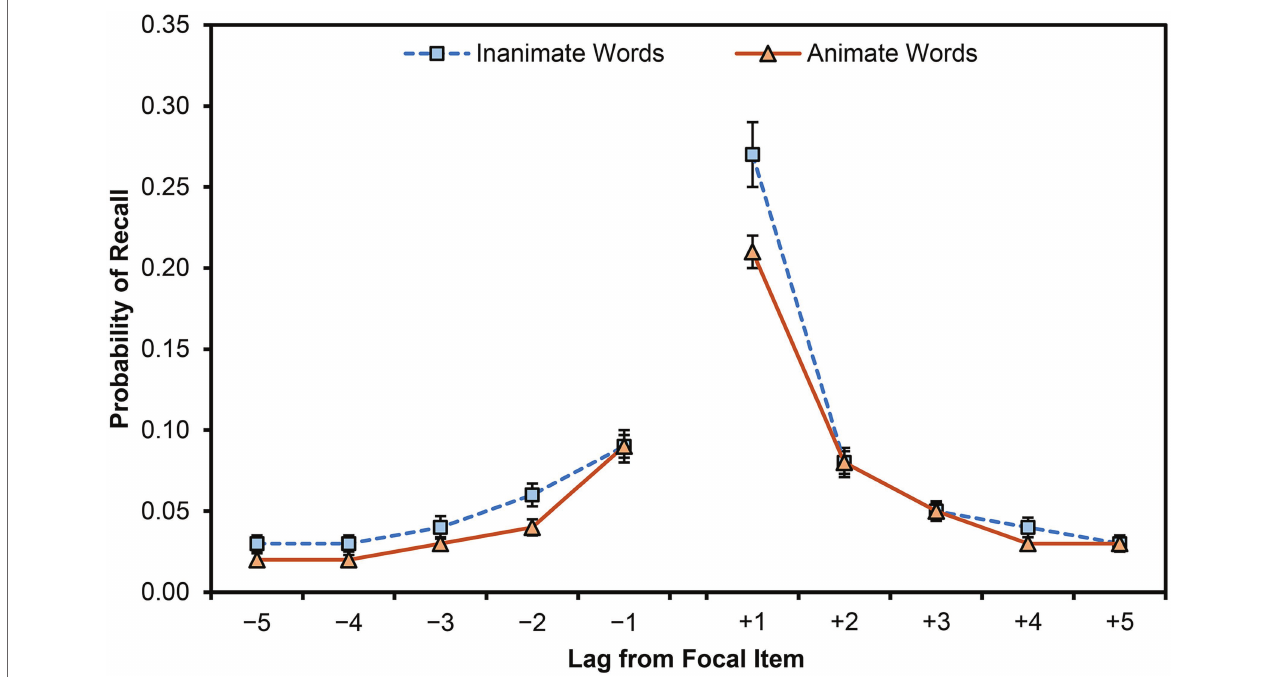
FIGURE 2 | The mean lag conditional response probability (lag-CRP), within ±5 lag positions, split by the animacy of the focal word. Results are collapsed on list number. Error bars are one